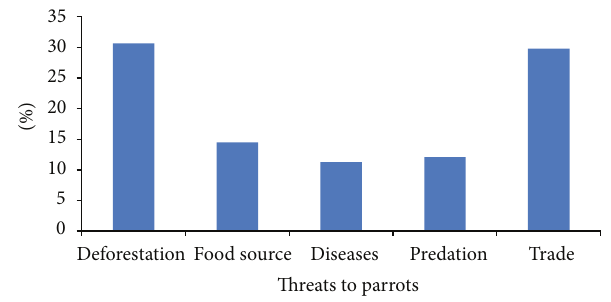
Figure 6: Percentages of threats to parrot distribution and abun- dance in